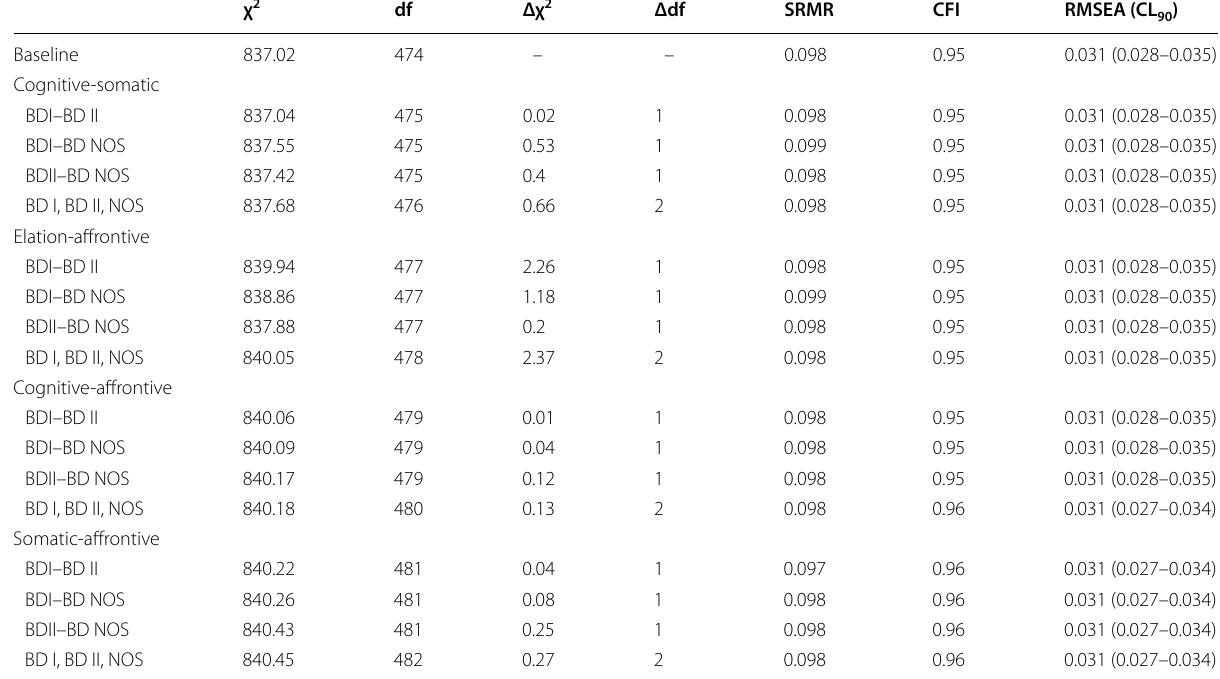
responses, between BD subtype comparisons x χ